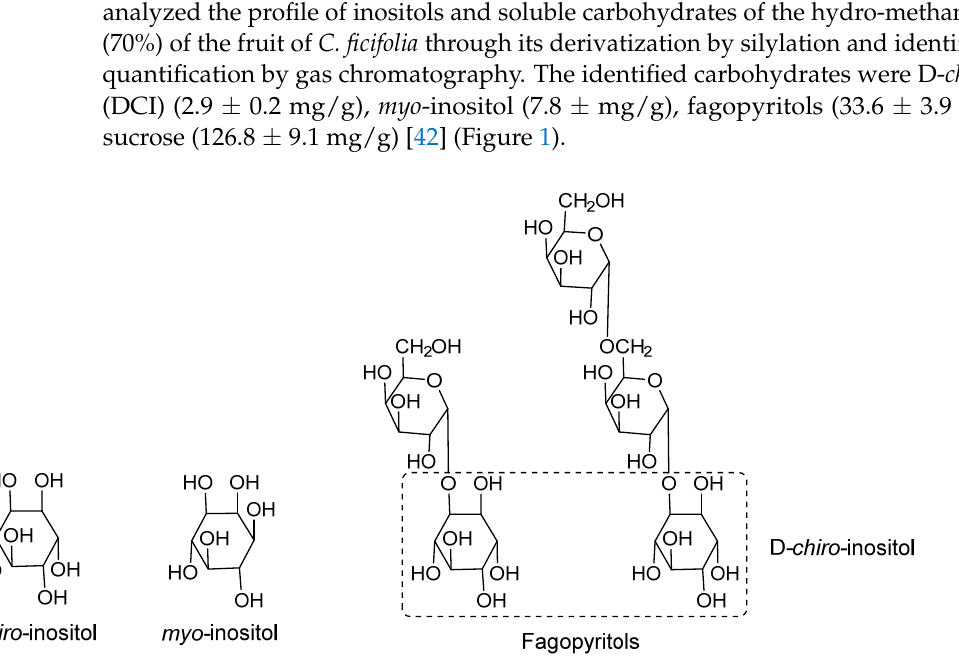
Figure 1. Identified molecules by gas chromatography in C. ficifolia extracts.